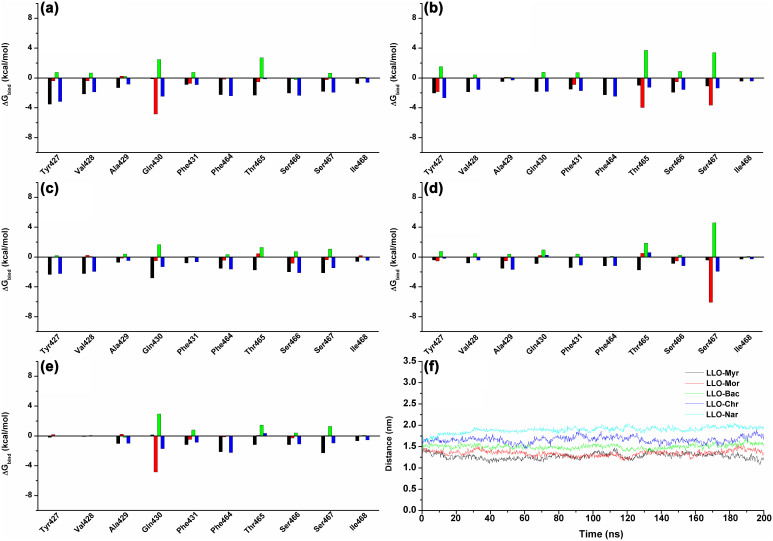
The decomposition of the binding energy on a per-residue basis in the binding sites of the LLO-Myr complex (a), LLO-Mor complex (b), LLO-Bac complex (c), LLO-Chr complex (d) and LLO-Nar complex (e). (black histograms: ΔEvdw; red histograms: ΔEele; green histograms: ΔEsol; blue histograms: ΔEtotal). The distances between Tyr427 and the 4H-chromen-4-one moiety of ligands in the complexes are shown as a function of time (f).